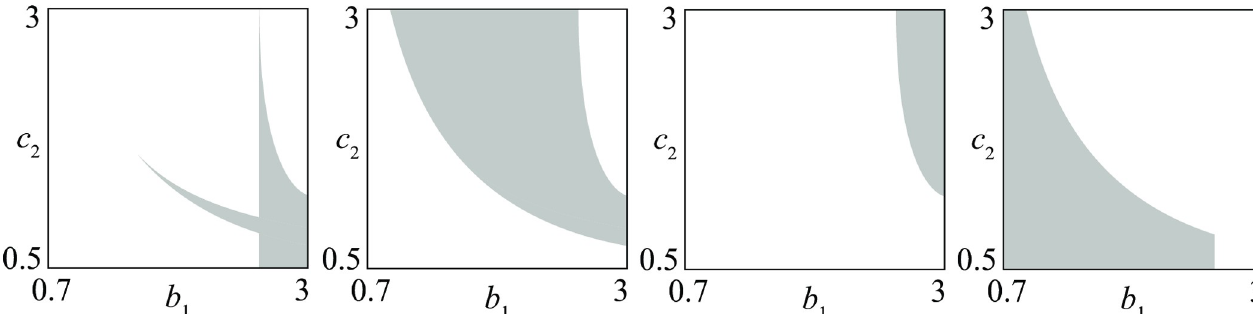
Fig 4. Four different sets of D—D conflicts (see text for their meanings).